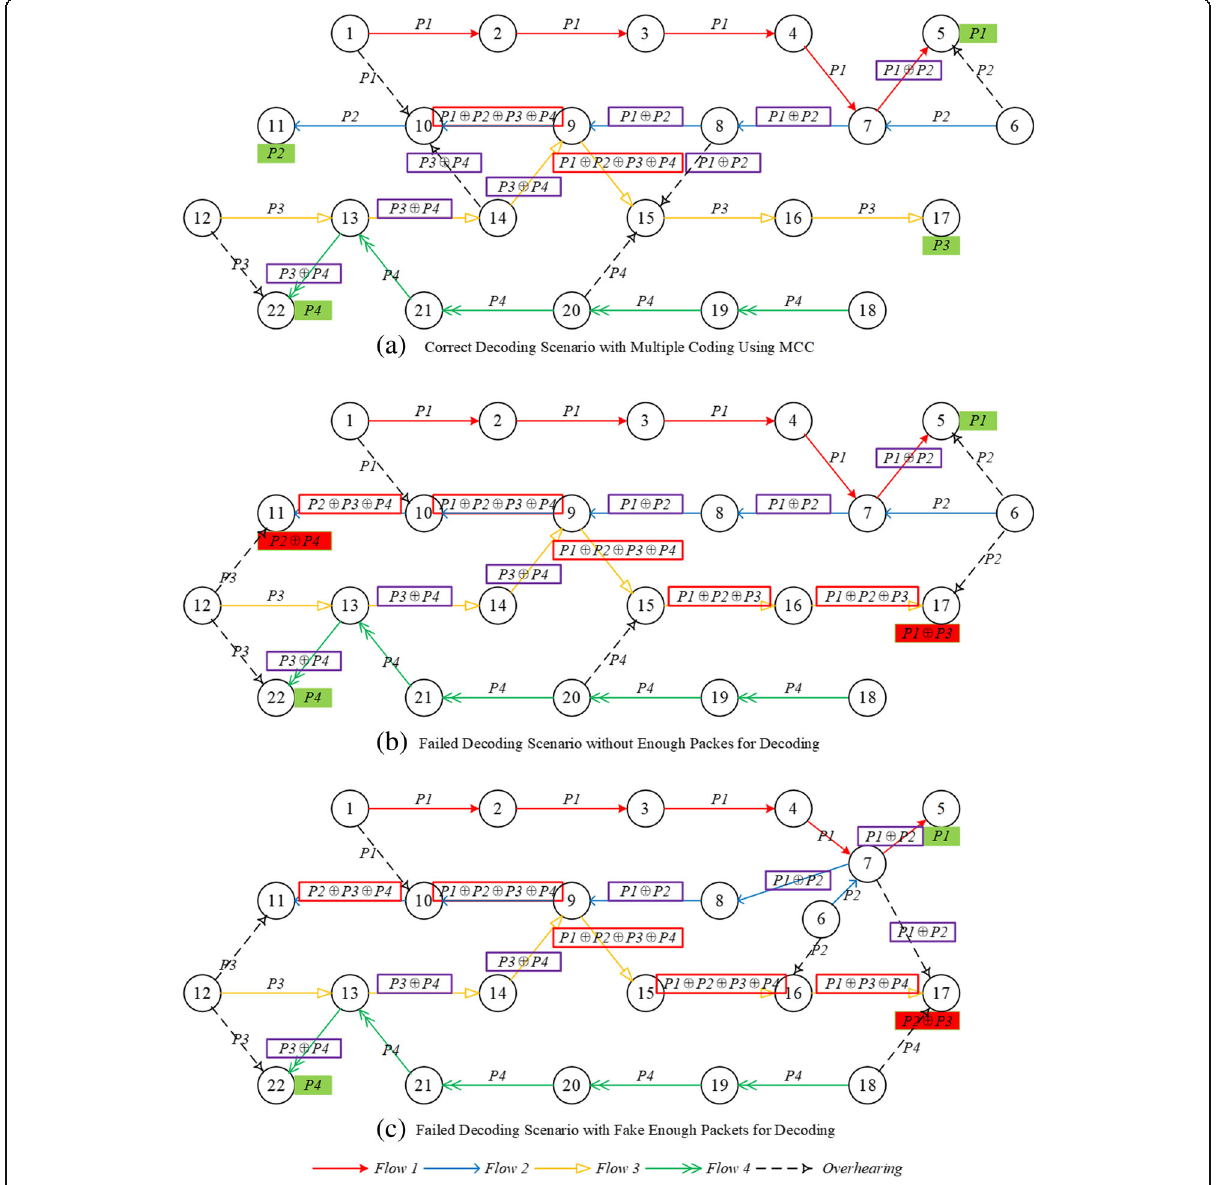
using GCC, and failed decoding problem in GCC. a Correct decoding scenario with multiple coding using MCC. b Failed decoding scenario without enough packets for decoding. c Failed decoding scenario with fake enough packets for